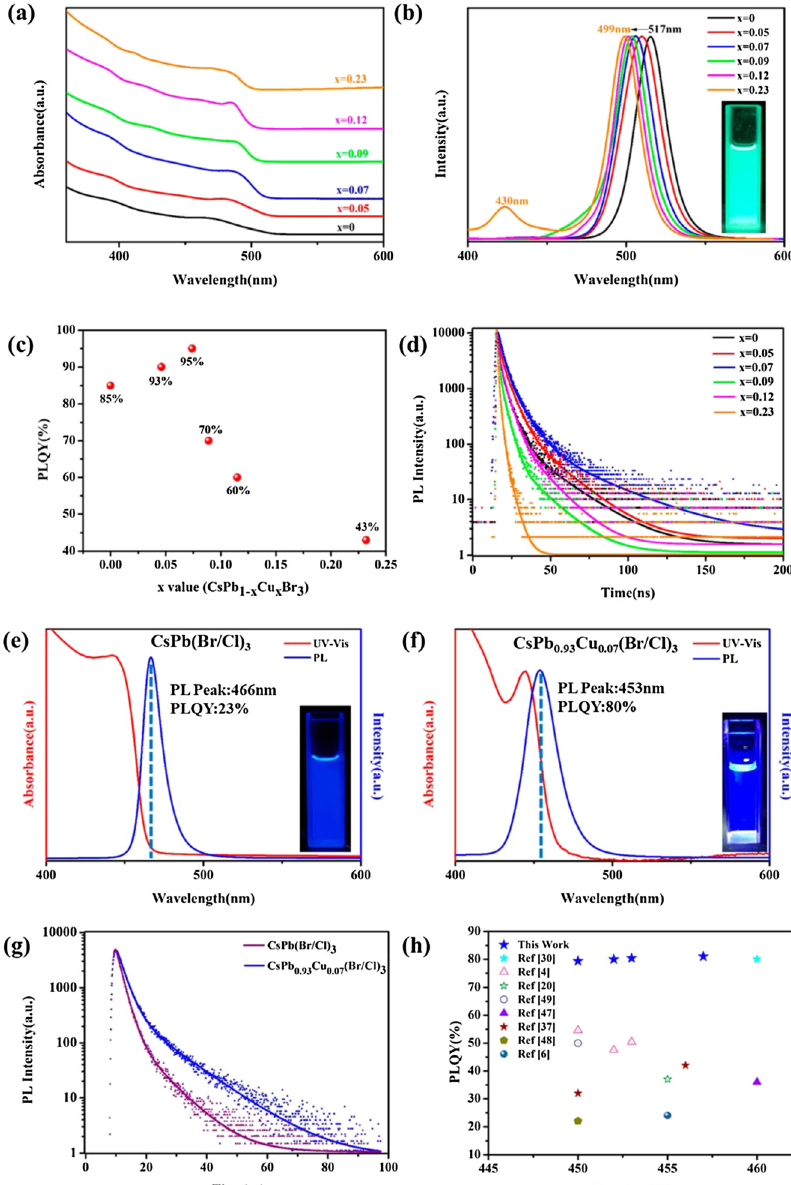
Figure 9: (a) Optical absorption, (b) PL spectra, (c) PLQYs, and (d) time-resolved PL decays (shown by dots; three-exponential fitting curves are given by solid lines) of CsPb 1 − x Cu x Br 3 QDs with different x values, as indicated on the frames. The inset